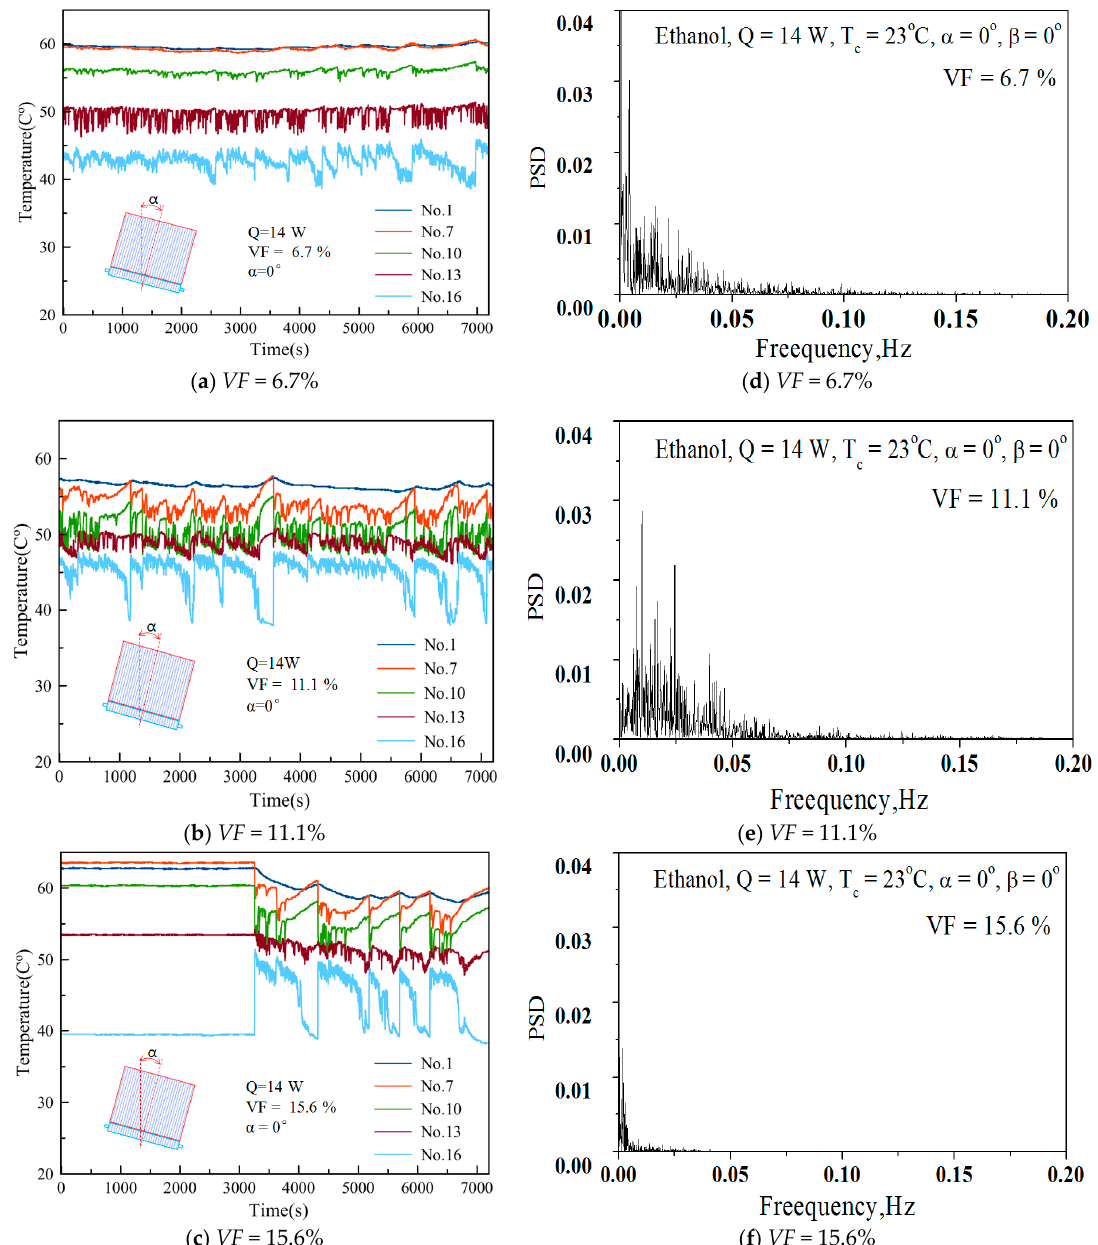
Figure 6. Transient Temperature Variation and FFT PSD Distribution (#No. 13), Q = 14 W.